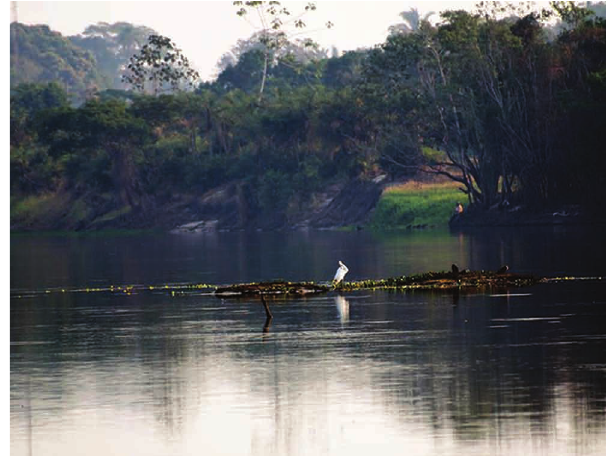
Fig. 7. Collection site of Corydoras guapore in the rio Guaporé, Mato Grosso State, Brazil, around the geographic coordinates 15°01.0642’S 59°95.762’W. Photo by Markos